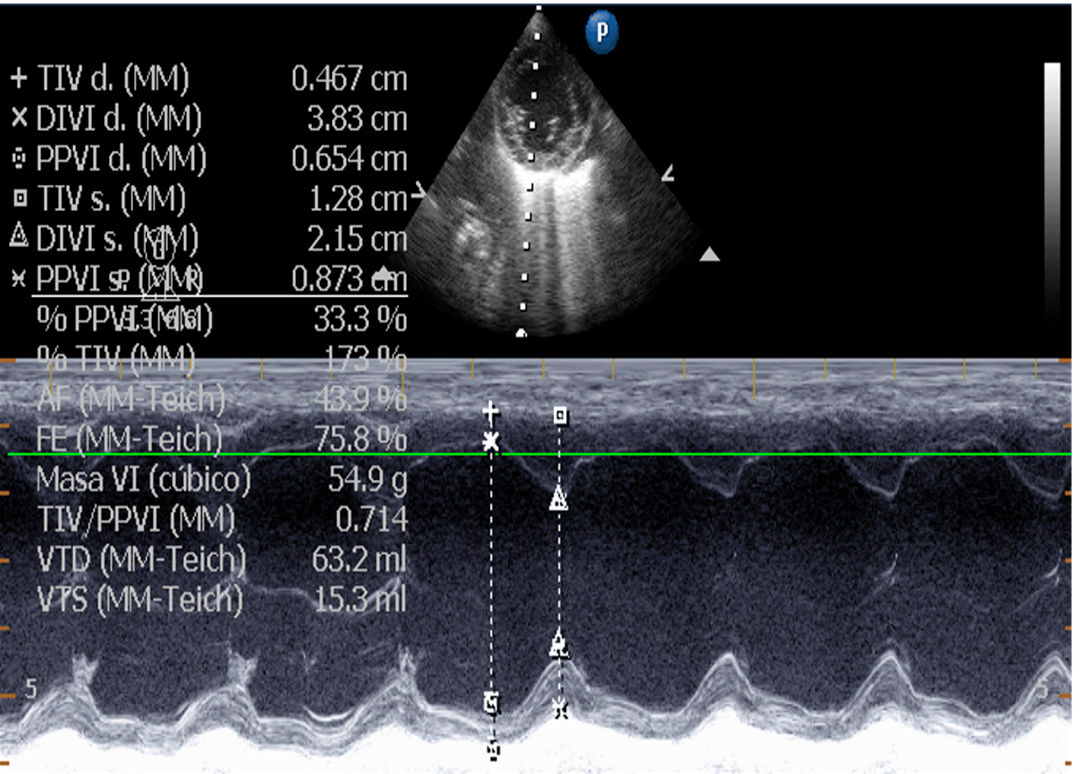
Figure 13. Left ventricular M-mode measurements in a dog.